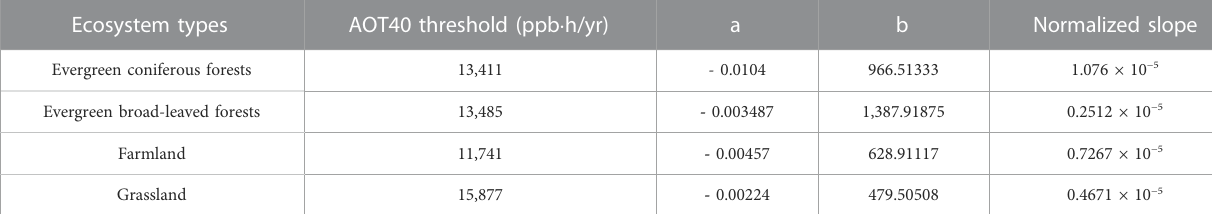
TABLE 3 AOT40 thresholds, a, b and normalized slopes for each